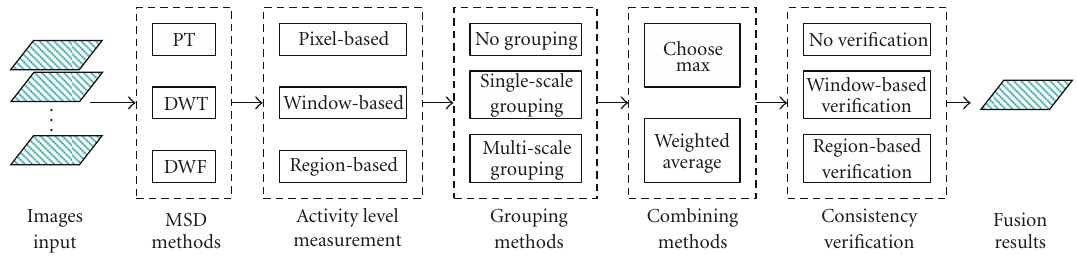
Figure 8: Generic framework for pyramid-based fusion schemes refers to